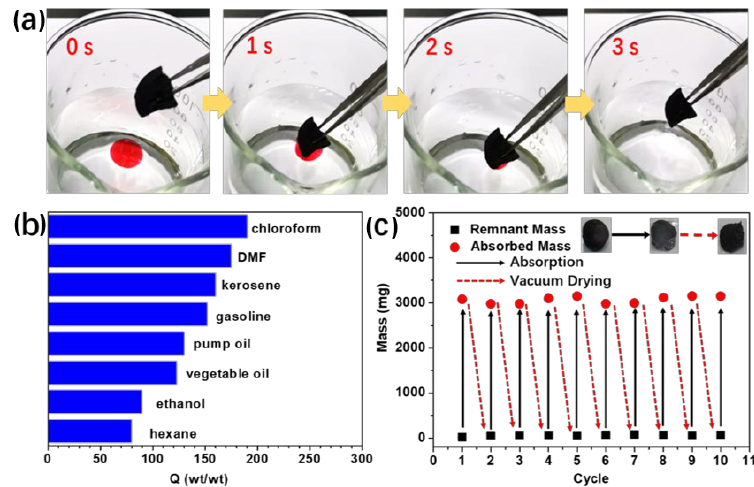
Figure 5. ( a ) Absorption of pump oil (colored with Sudan III for clear presentation) by SWNT aerogels within 3 s. ( b ) Absorption capacities of SWNT aerogels for various organic solvents. ( c ) Reusability of SWNT aerogels for kerosene absorption.